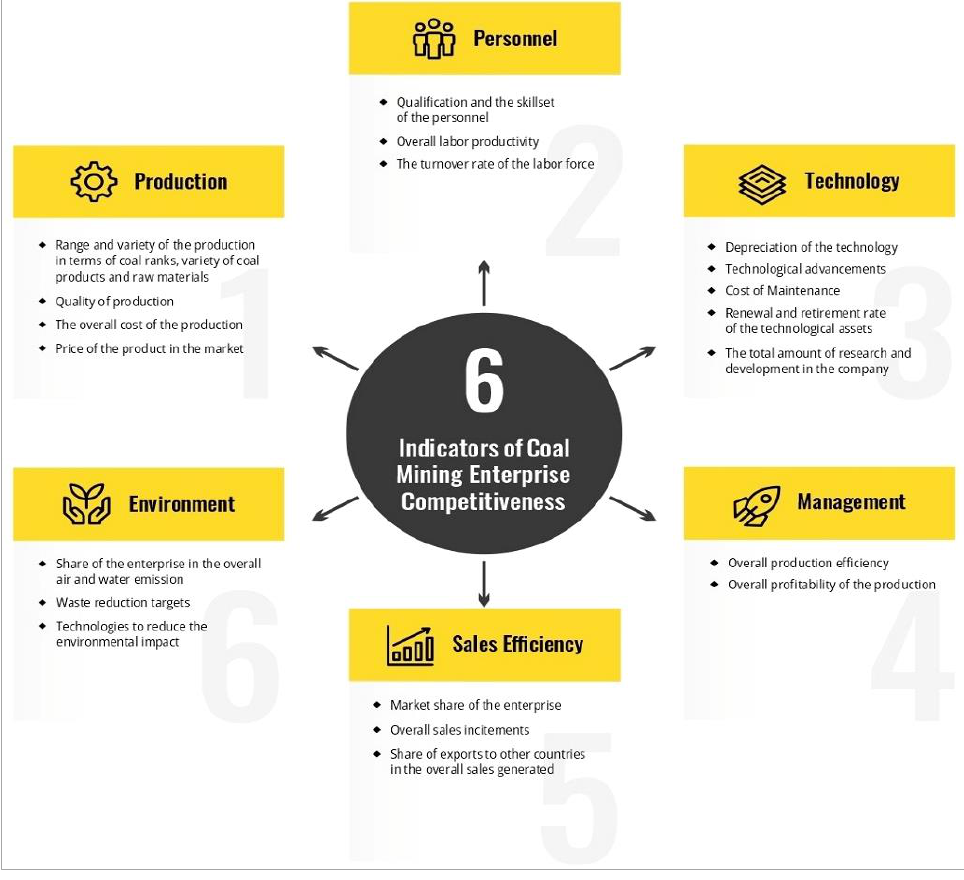
Figure 6. Indicators for assessing the competitiveness of a coal mining